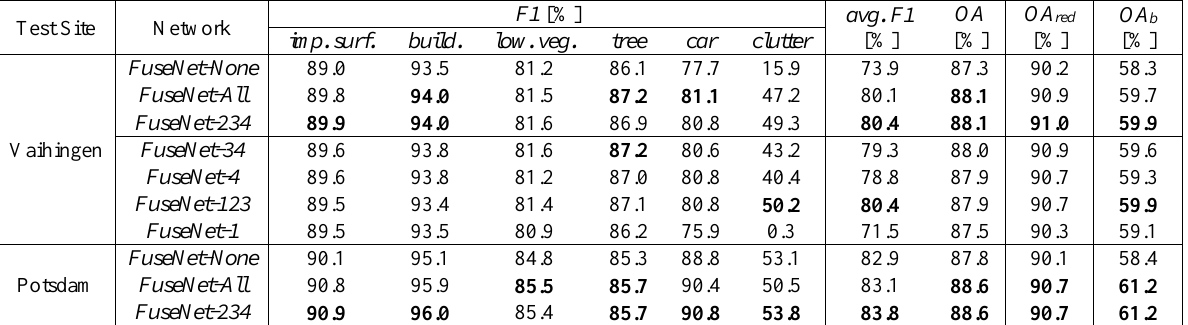
Table 2. Results of land cover classification for different network variants defined in Table 1 using the extended focal loss (eq. 4) for training. F1 : F1 score, OA : Overall Accuracy, both determined on the basis of the full reference; OA red : Overall Accuracy based on the eroded reference; OA b : Overall Accuracy for pixels in the boundary areas. Best scores per test site and metric are printed in bold